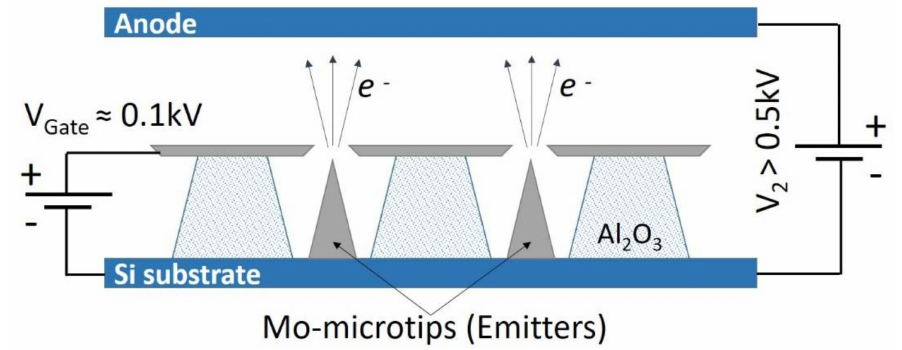
Figure 2. Schematic of Spindt-type